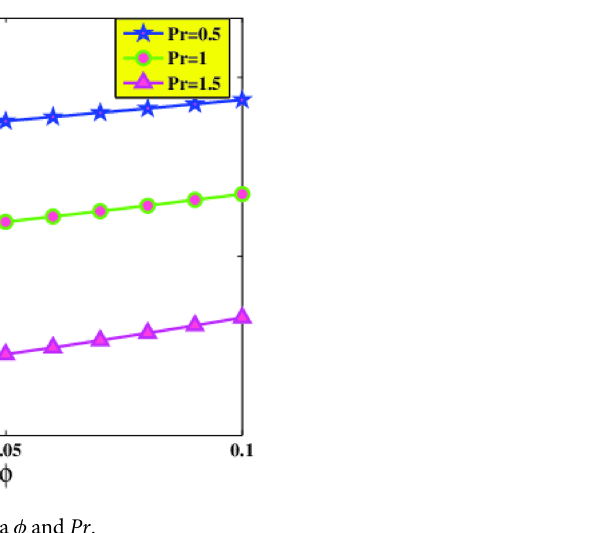
Figure 13. Nusselt number Nu x via φ and Pr